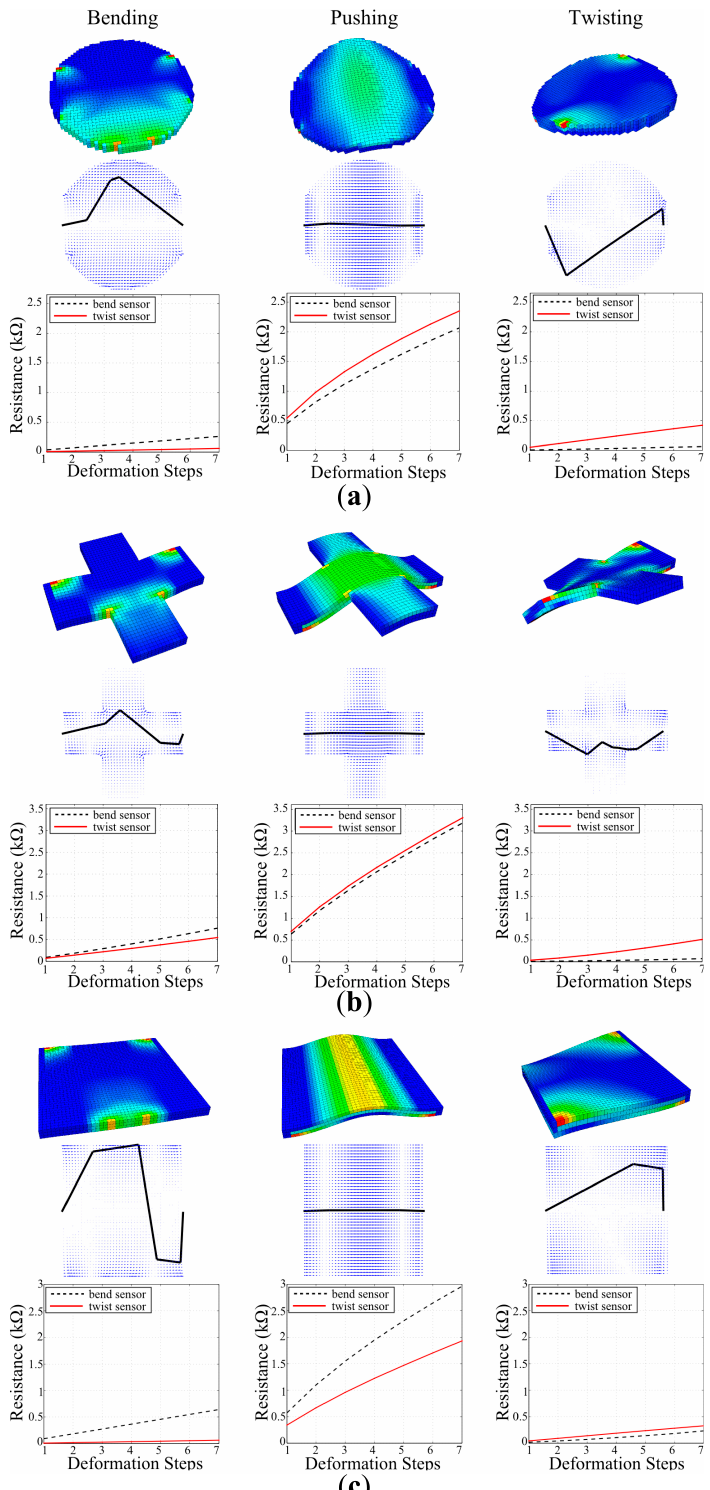
Figure 4. Simulation experiments of three shapes. Columns represent bending, pushing and twisting deformations respectively. First rows show VoxCad deformations with lighter colors representing larger strain and second rows show strain vectors with black lines representing designed sensor morphologies. Third rows show simulation estimates of sensors using Equation (8) with CTPE material’s sensor properties. Deformation steps correspond to 1N of increase for bending and pushing, and 1 Nmm for